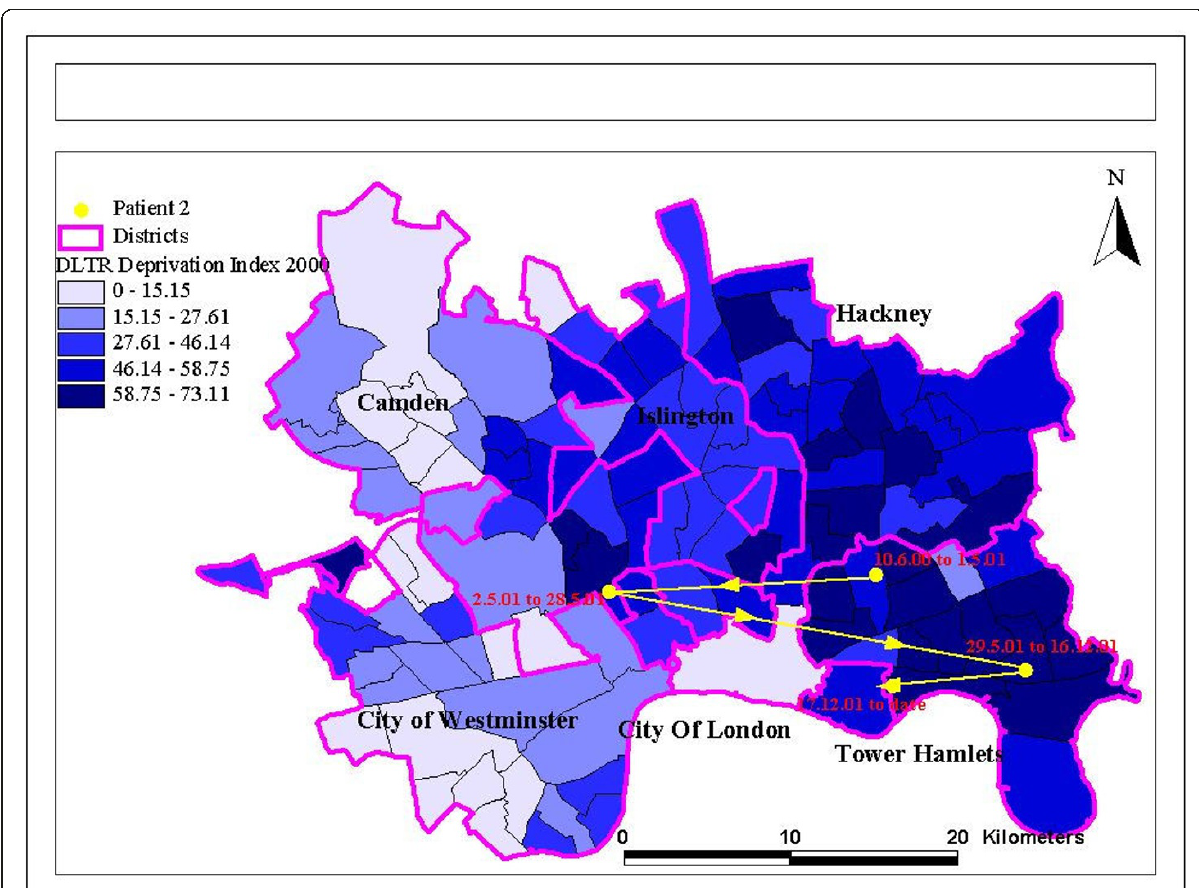
Figure 1 Mapping mobility between different levels of area deprivation